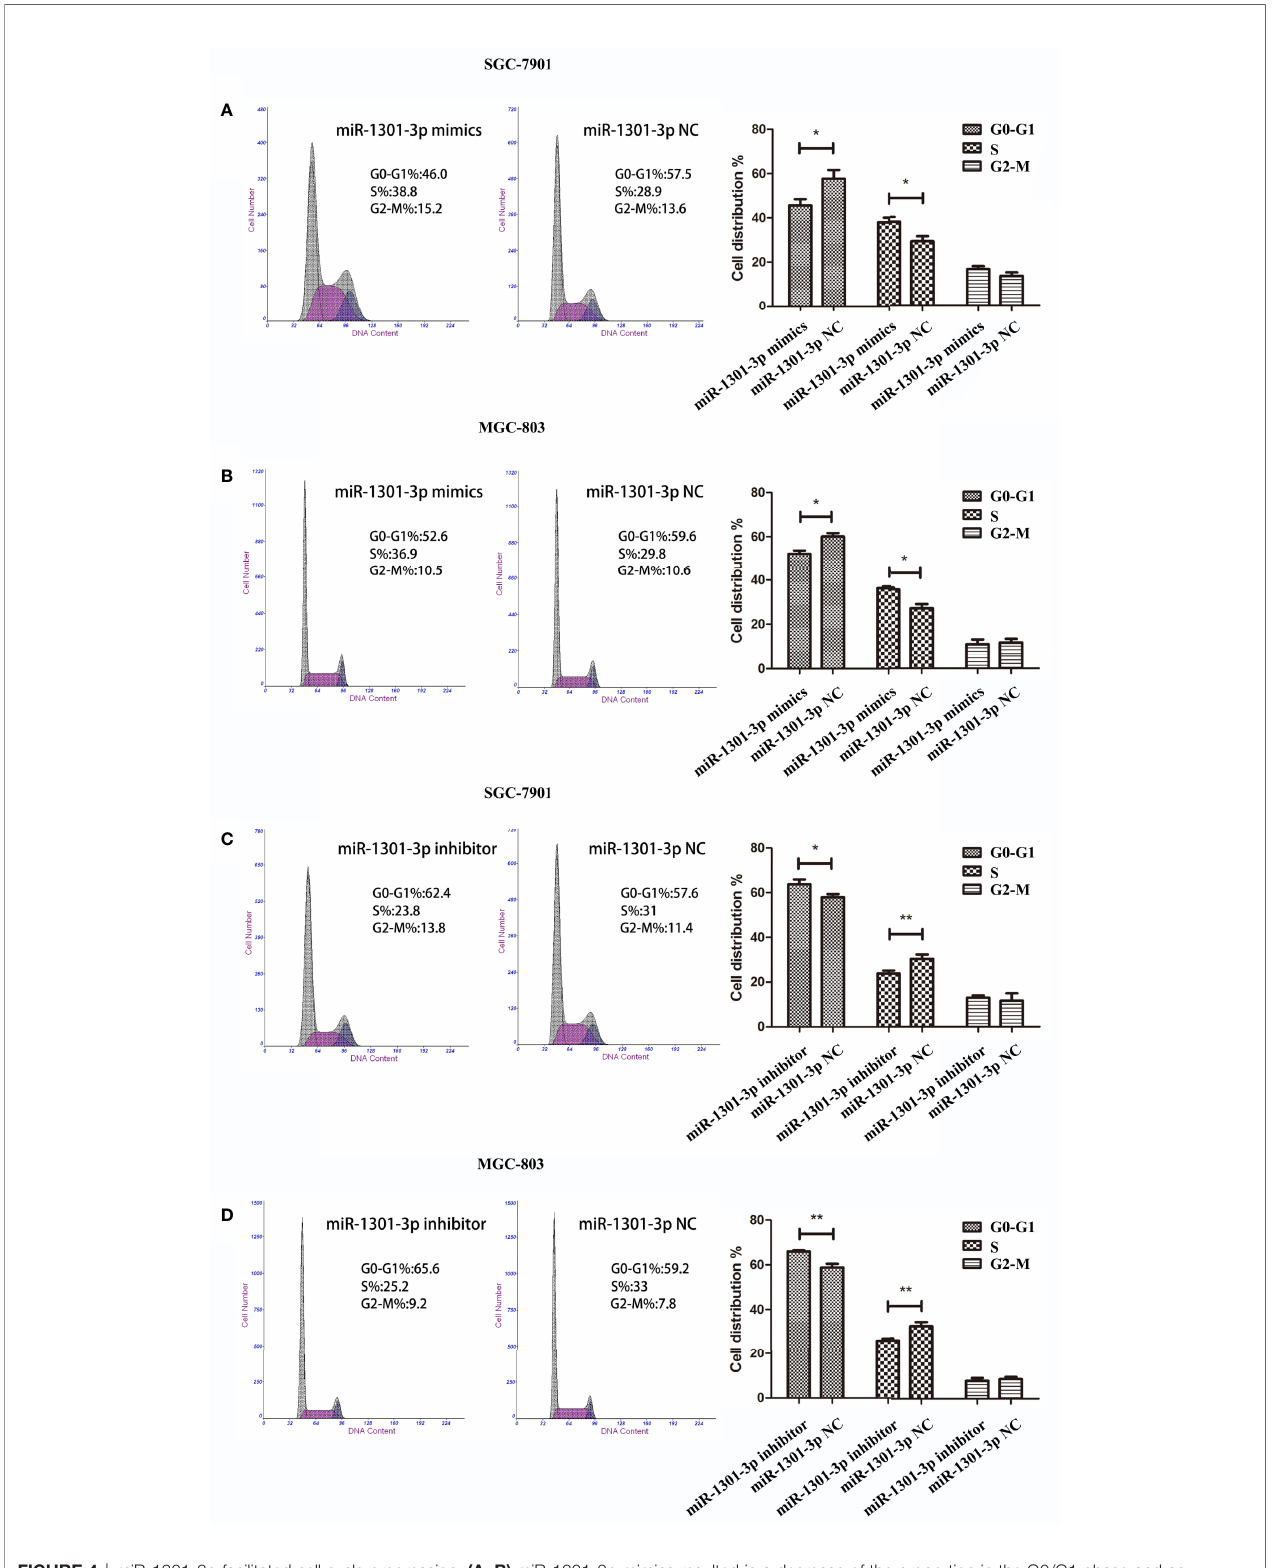
FIGURE 4 | miR-1301-3p facilitated cell cycle progression. (A, B) miR-1301-3p mimics resulted in a decrease of the proportion in the G0/G1 phase and an increase of the proportion in the S phase compared with the control. (C, D) miR-1301-3p inhibitor increased the proportion in the G0/G1 phase and decreased the proportion in the S phase compared with the control. *p < 0.05, **p <